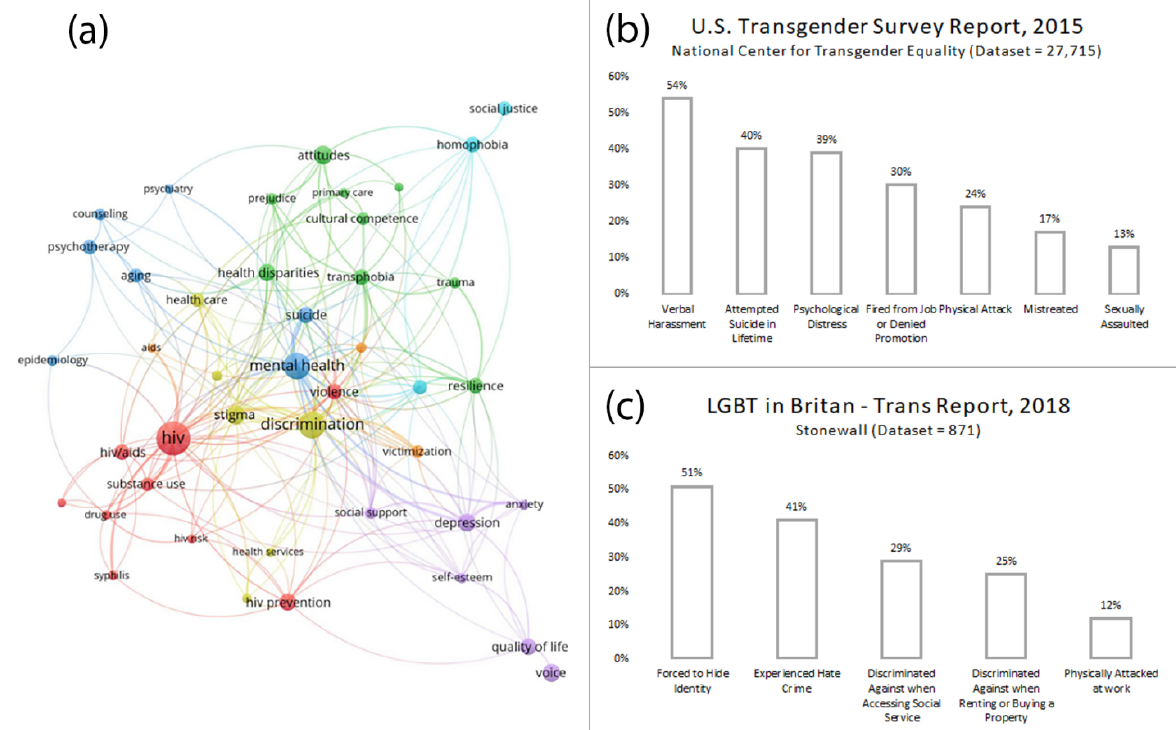
Figure 1: (a) Inter-relationship of different health-related keywords extracted and analyzed from 5772 peer reviewed articles by Sweileh [1] (The figure was reproduced under the creative commons licence). Different experiences that transgender people face in (b) USA and in (c)